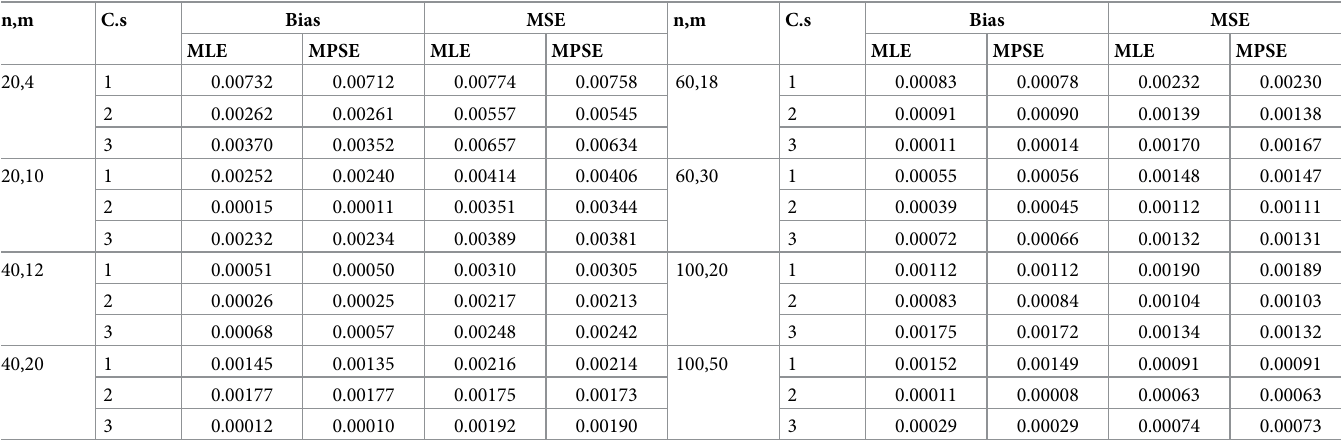
¼ X m for different censoring schemes when θ = 0.4.. 1 4